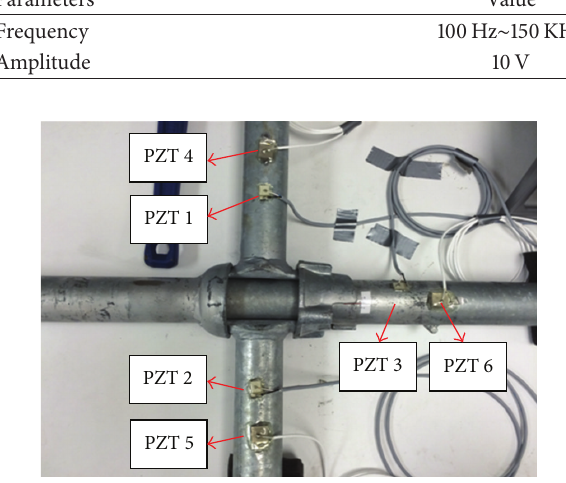
Figure 6: Cuplock scaffold structure